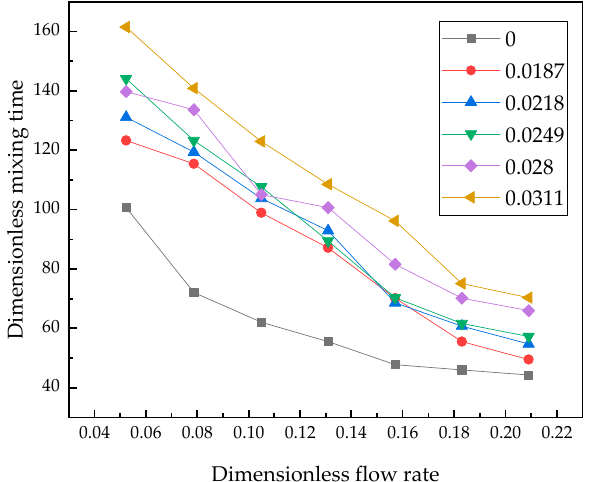
Figure 11. The relation of dimensionless mixing time and dimensionless flow rate in the ladle with double porous plugs.